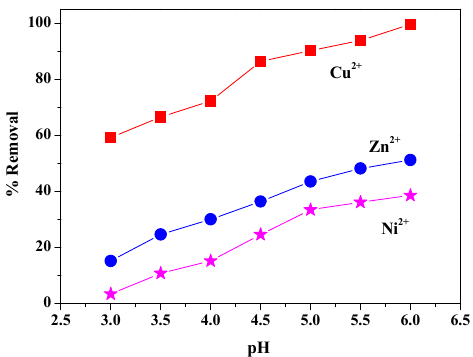
Figure 8. Effect of pH of heavy metal ions solution on removal rate (adsorbent:1 g/L, heavy metal ions concentration:100 mg/L, 298 K, 4 h).